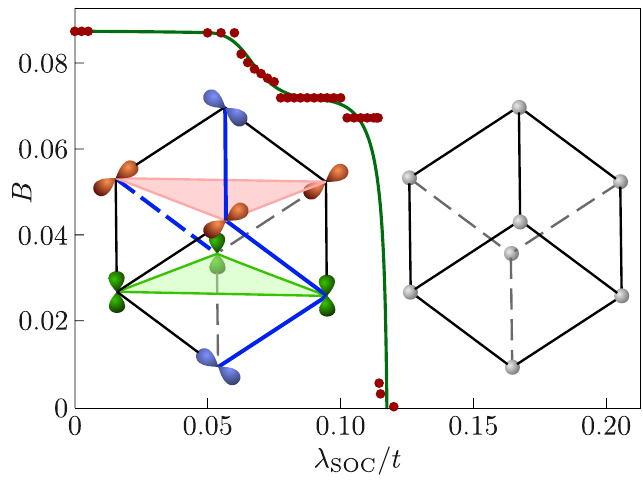
Figure 1: The value of the bond density order parameter B , as a function of the strength of spin orbit coupling λ , which is measured in units of the bandwidth t . SOC The points are self-consistent numerical solutions of the set of equations in Eq. (4), while the solid line connecting them is a guide to the eye only. The unordered state at / t corresponds to the simple cubic lattice structure of α − Po, as shown in the high λ SOC right inset. In the ordered state, the planes perpendicular to the cube’s body diagonal move closer together, by means of a contraction of the thick bonds shown in blue in the left inset. The result is the spiral trigonal lattice structure known to be realised in Se and Te. Because the structural transition is the result of three simultaneous density wave instabilities, each occurring in chains of distinct orbitals, the trigonal state necessarily is also an orbital ordered state. The least occupied orbitals in each trigonal plane are highlighted in the left